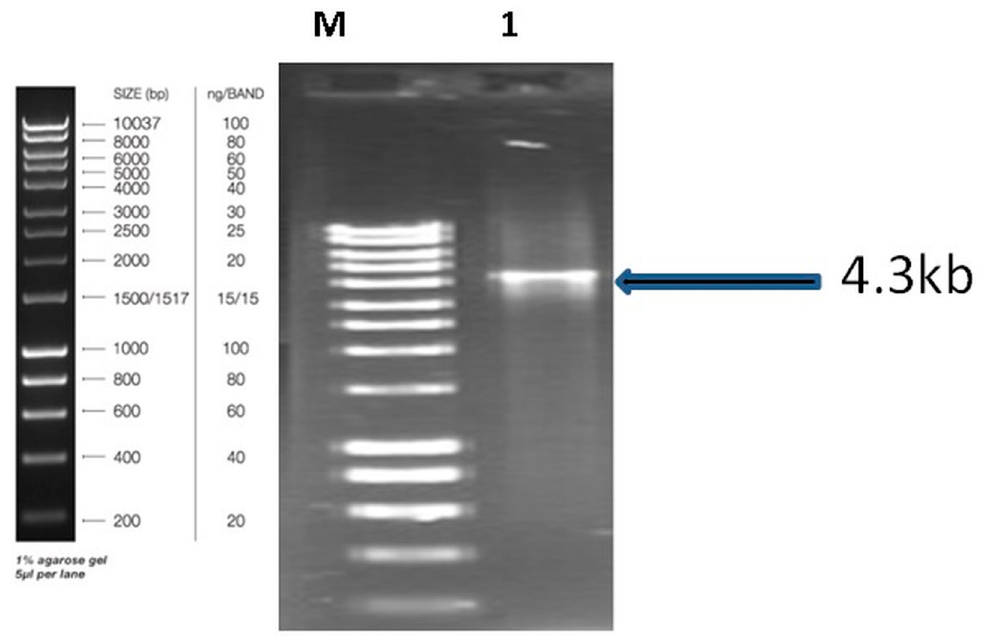
Figure 1. Lane 1 ~4.5 kb fragment was obtained using the FHDOPST_Forward/RHDOECO_ reverse primer set on genomic DNA of Alcanivorax sp. HA03 (lane 1). Lane M, molecular weight Hyperladder I (Bioline).